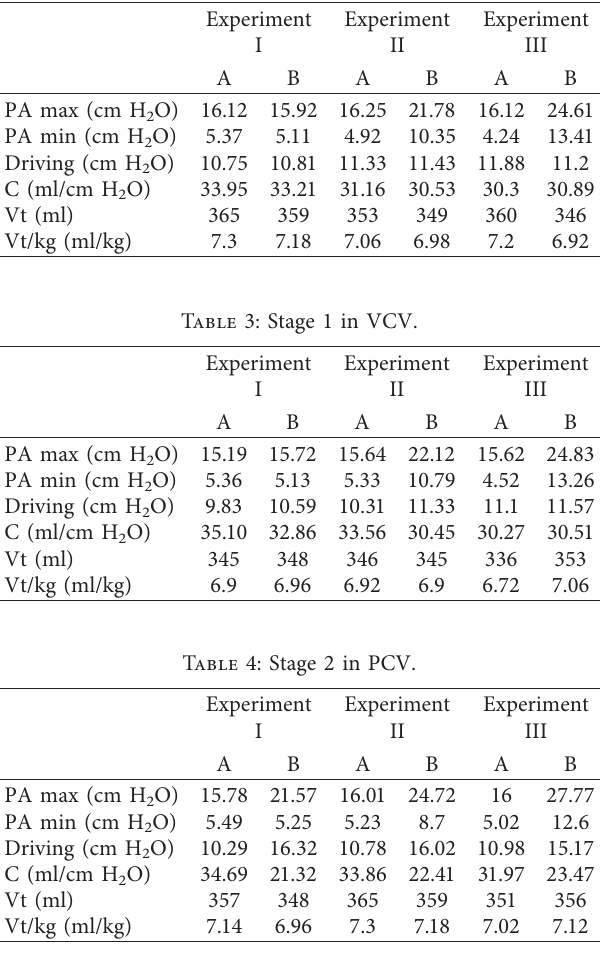
Table 2: Stage 1 in PCV.